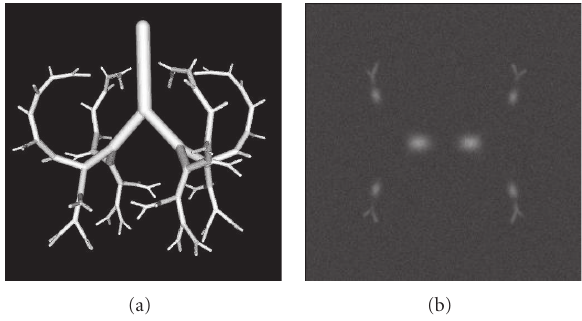
Figure 5: Visualization of the phantom data. (a) Surface display of the simulated vascular tree. (b) Cross-section of a phantom subjected to Gaussian noise of standard deviation σ = 30. The model contains 62 branchpoints and 125 segments. Intensity values at the center of the segments vary depending on the radius of the segment to mimic vessels in typical thoracic CT images. Gaussian noise with di ff erent standard deviations was